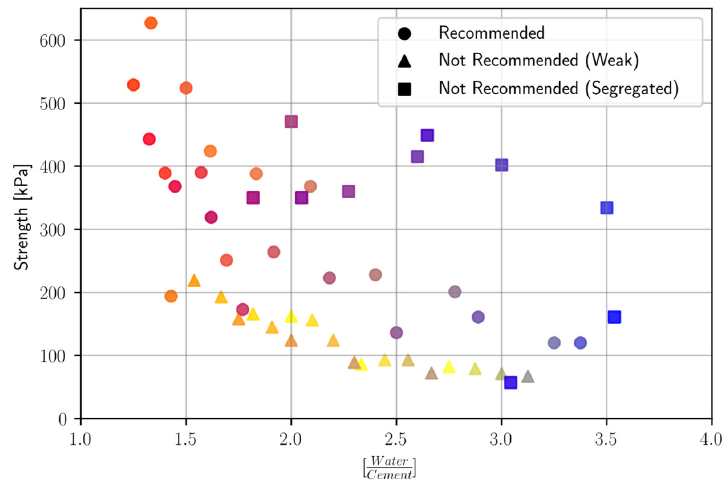
Figure 11. Strength vs. water/cement ratio.